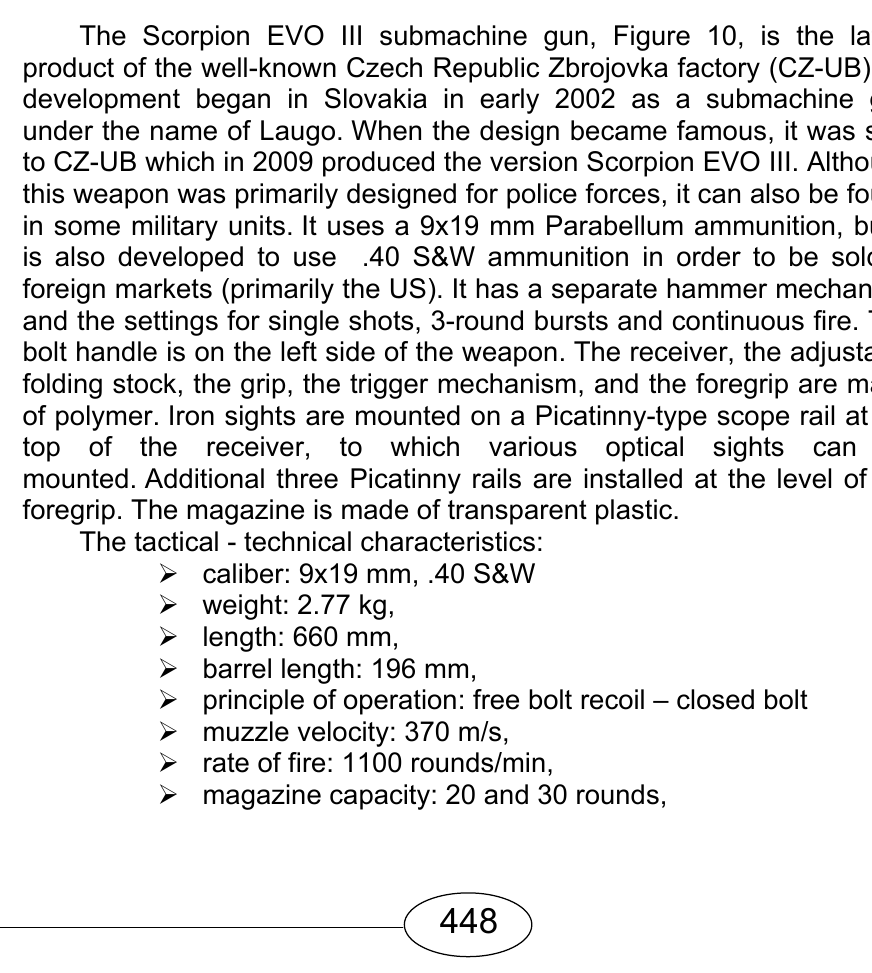
Figure 9 – Brugger & Thomet MP9 Submachine gun Рис . 9 – Автомат Brugger & Thomet MP9 Слика 9 – Аутомат Brugger & Thomet